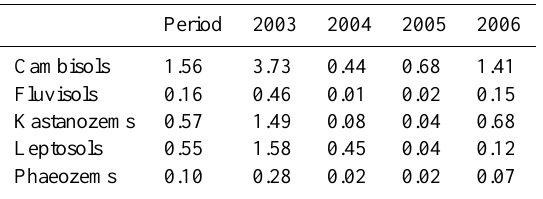
Table 2. Soil-specific sediment yields (SSY; tha − 1 year − 1 ) simu- lated by SWAT for the period 2003–2006.